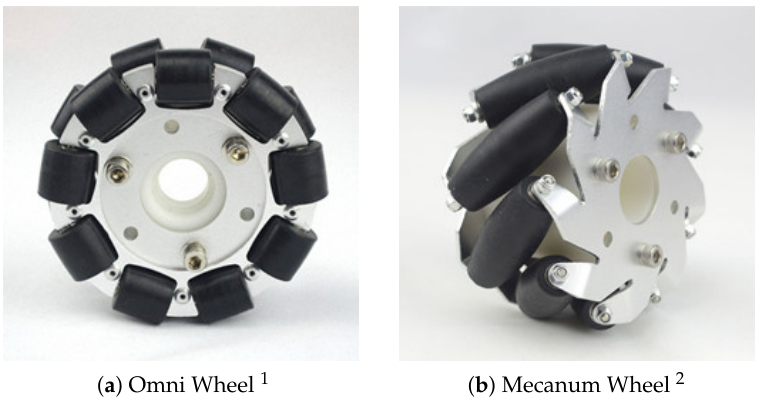
Figure 2. The example of omnidirectional wheels. ( 1 https://www.nexusrobot.com/product/4- inch100mm-double-aluminum-omni-wheel-bearing-rollers-14054.html, accessed on 18 January 2023. 2 https://www.nexusrobot.com/product/4-inch-100mm-mecanum-wheel-rightbearing-rollers-14 094r.html, accessed on 18 January